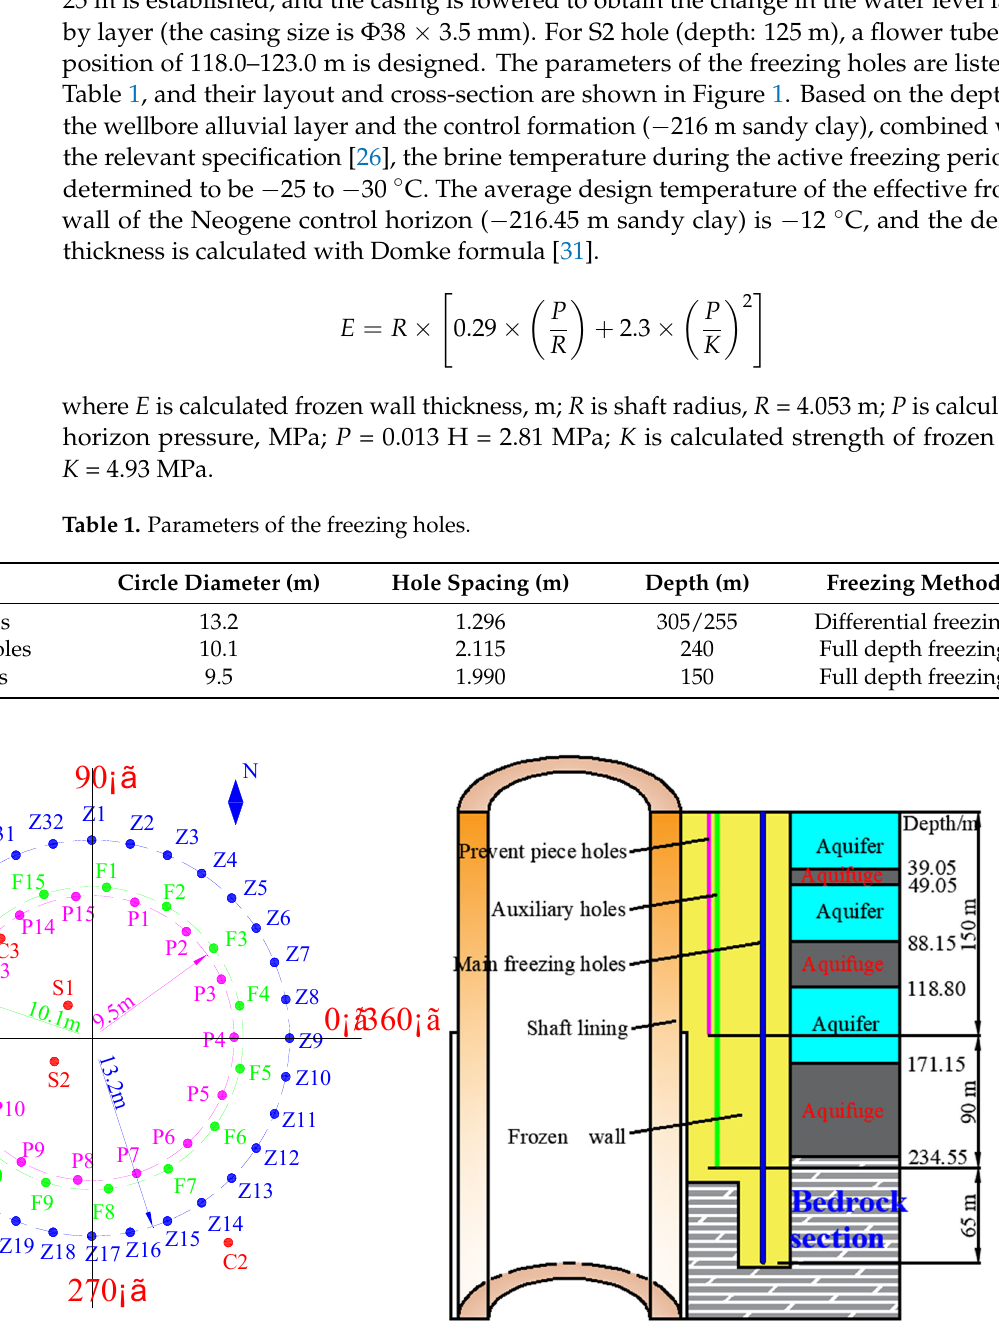
Figure 1. Plan layout and cross ‐ section of the freezing holes. Z: main freezing hole; F: auxiliary hole; P: prevent piece hole; C: temperature measurement point; S: hydrological observation hole.